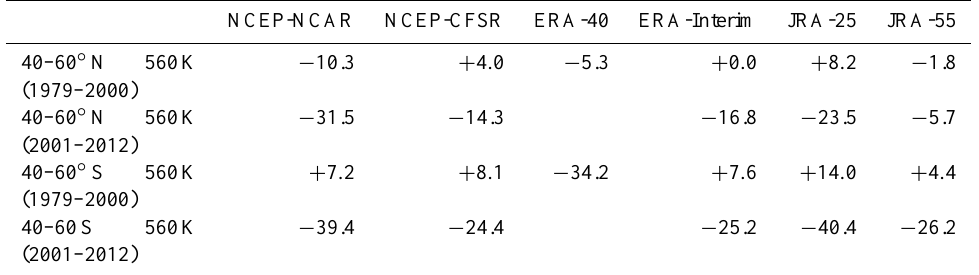
Table 2. Linear trend slope of K yy ( l = 1 month) (in %decade − 1 ) for 40–60 ◦ N in DJF and for 40–60 ◦ S in JJA at 560K during the first 22 years (1979–2000) and during the last 12 years (2001–2012). None of the linear trend has a confidence level of